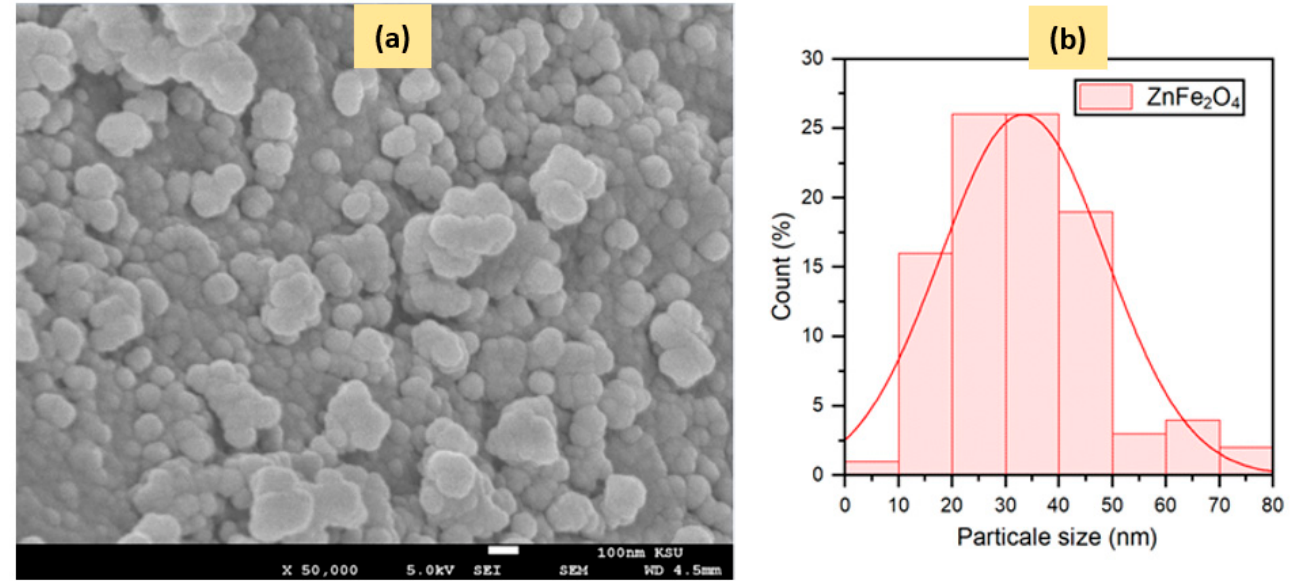
Figure 4. ( a ) SEM images of ZFNPs and ( b ) particle size distribution.